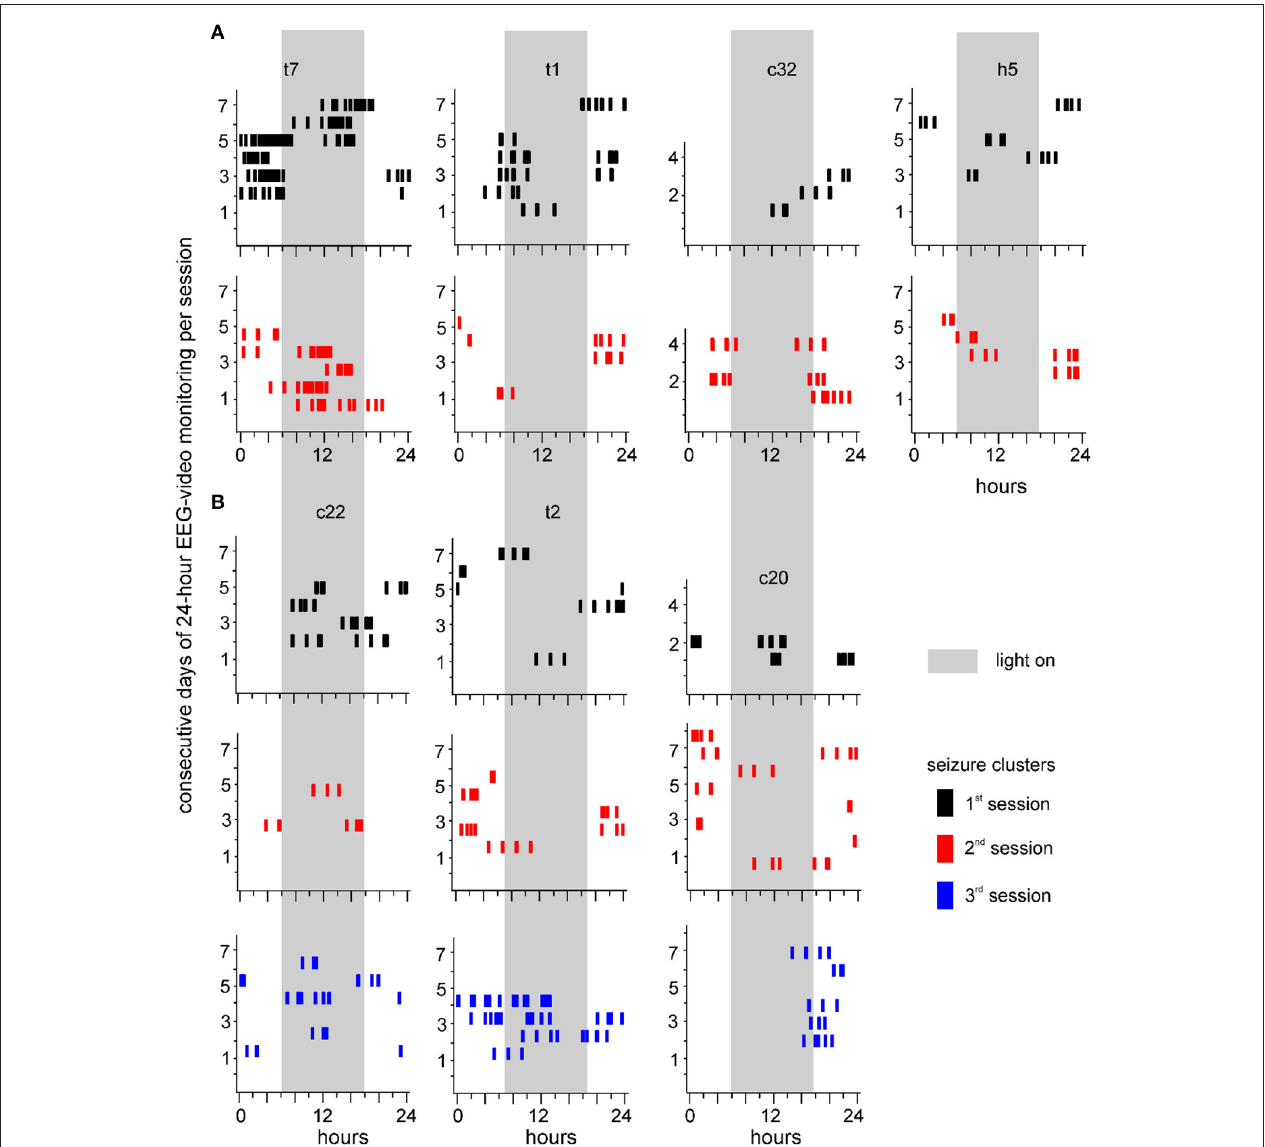
FIGURE 5 | Seizure clusters recognized during 3 sessions of 24-h EEG-video monitoring. Seizure clusters recognized from 7 individual mice over 2 (A) or 3 (B) monitoring sessions are presented in each plot. Mice are named by small letters and numbers, with “c, h, or t” standing for unstimulated cortical, hippocampal, or thalamic area, respectively. Y-axis – consecutive days of 24-h EEG-video performed in individual mice. X-axis – 24h of the day. Long gray bars – the light-on period (6 am to 6 pm). Seizure clusters detected in the first, second, or third sessions are denoted by black, red, or blue vertical bars, respectively. Note persistent but variable seizure cluster expressions in individual